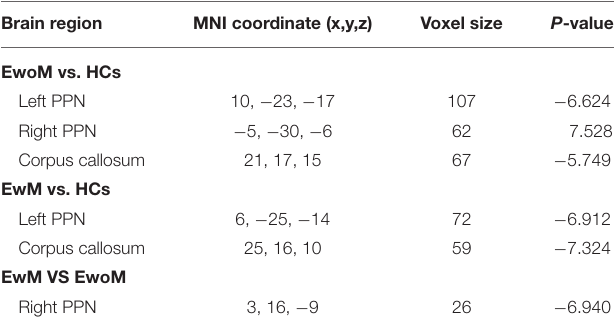
TABLE 2 | Regions with significant difference of RsFC between-groups.